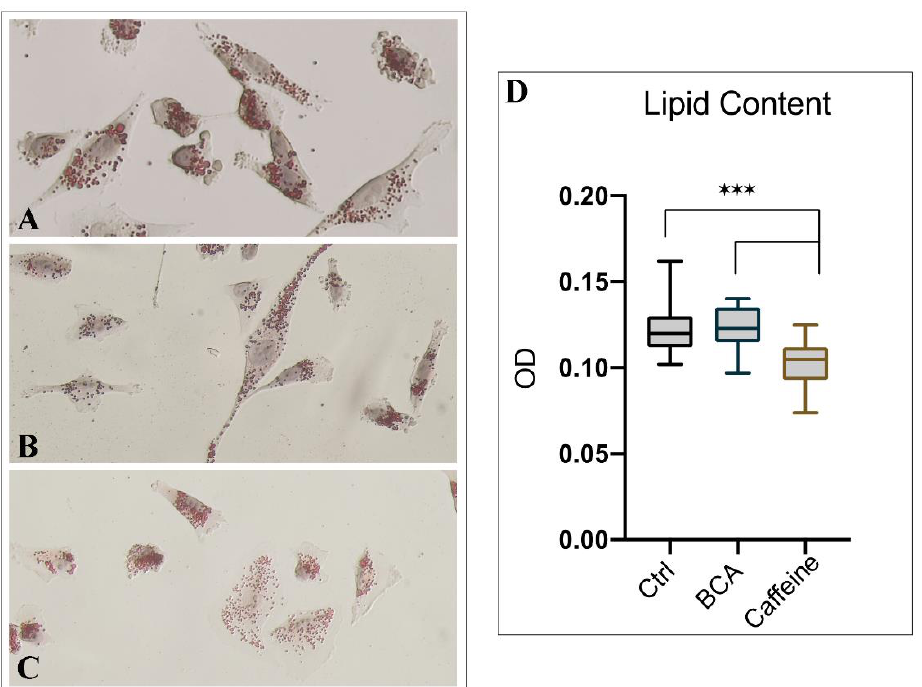
7 of 14 Figure 5. TAS2Rs protein expression in the hGL5 cell line. ( A ) Representative images of three inde- pendent western blot analysis of TAS2Rs after treatment with BCA and caffeine. β -actin was used as a loading control. ( B ) Relative quantification of western blotting band intensities. 2.5. BCA and Caffeine Affect Intracellular Lipid Storage and Steroid Secretion A close relationship between taste receptors and steroid hormones has been demon- strated thus far. Therefore, to assess whether the effect of BCA and caffeine (two recog- nized agonists of TAS2Rs) on mitochondria may be a steroidogenic input, we evaluated the shape and the load of hGL5 lipid droplets. These latter are indeed of functional im- portance in steroidogenesis, as they store cholesterol substrate for the synthesis of steroid hormone. Changes in the morphology of lipid droplets in hGL5 treated with caffeine and BCA were evaluated using Oil red O staining and are shown in Figure 6A. Morphological changes in lipid droplets manifested by fusing with each other, and its size changed after fusion. In hGL5 treated with caffeine, smaller lipid droplets may be observed, which were generally spherical in shape (Figure 6B). In contrast, BCA-treated hGL5 tended to form relatively larger lipid droplets, which were shown to be spherical or irregular (Figure 6C). Intracellular lipids within hGL5 were also measured by Oil red O extraction. As shown in Figure 6D, we found that lower amounts of lipids were deposited in hGL5 cells after 24 h of in vitro culture with caffeine. Additionally, after Oil red O staining, the color of lipid